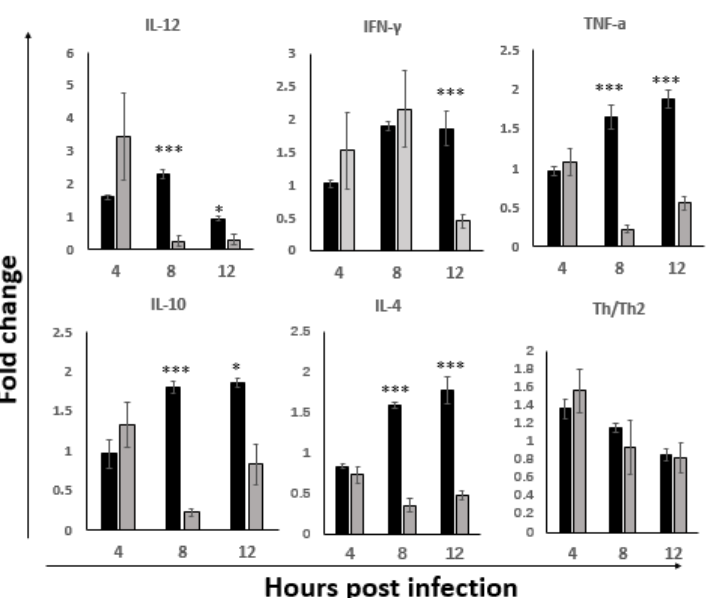
Figure 7. Differential modulations of Th1 and Th2 cytokine response in the ILP cells at the early stage